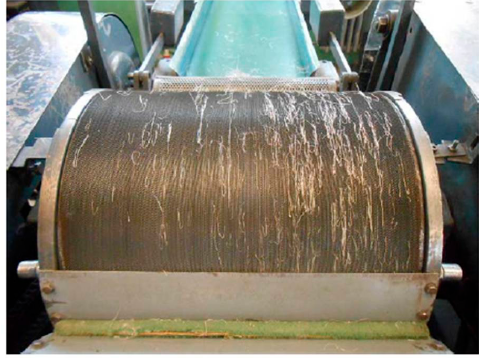
Figure 5. Adherence of the fibers to the drum during the carding process.